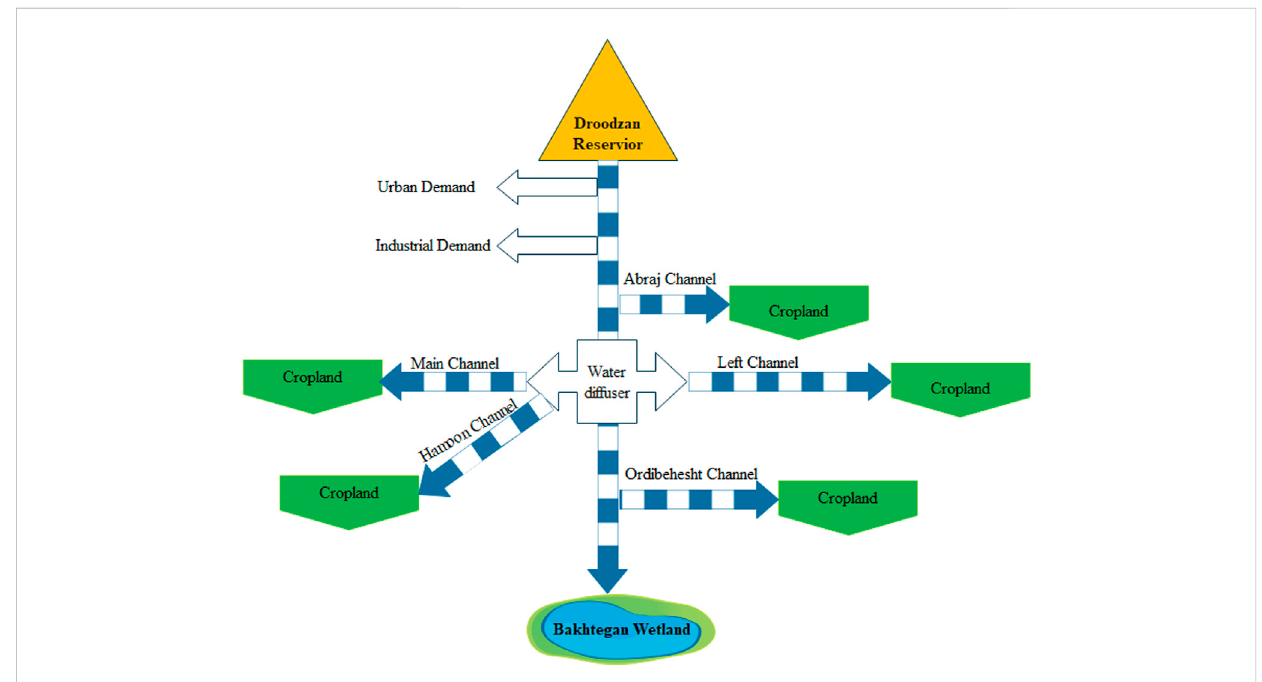
FIGURE 2 Schematic of the irrigation network channels of doroodzan